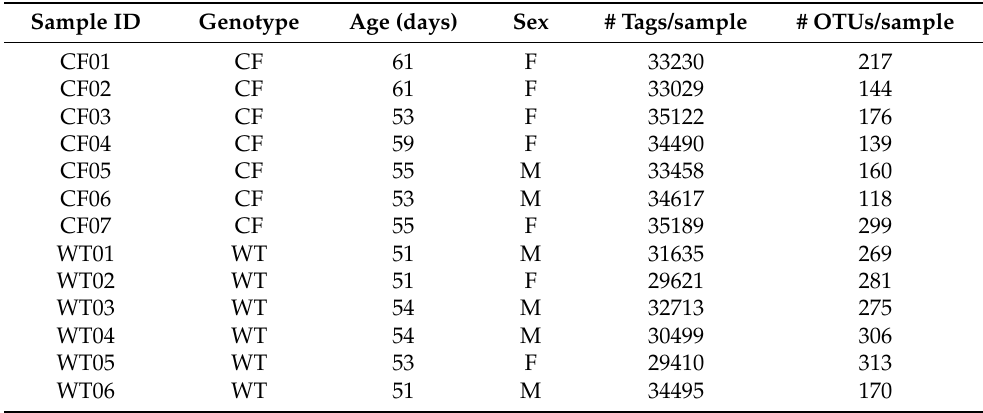
Table 1. Study sample description.